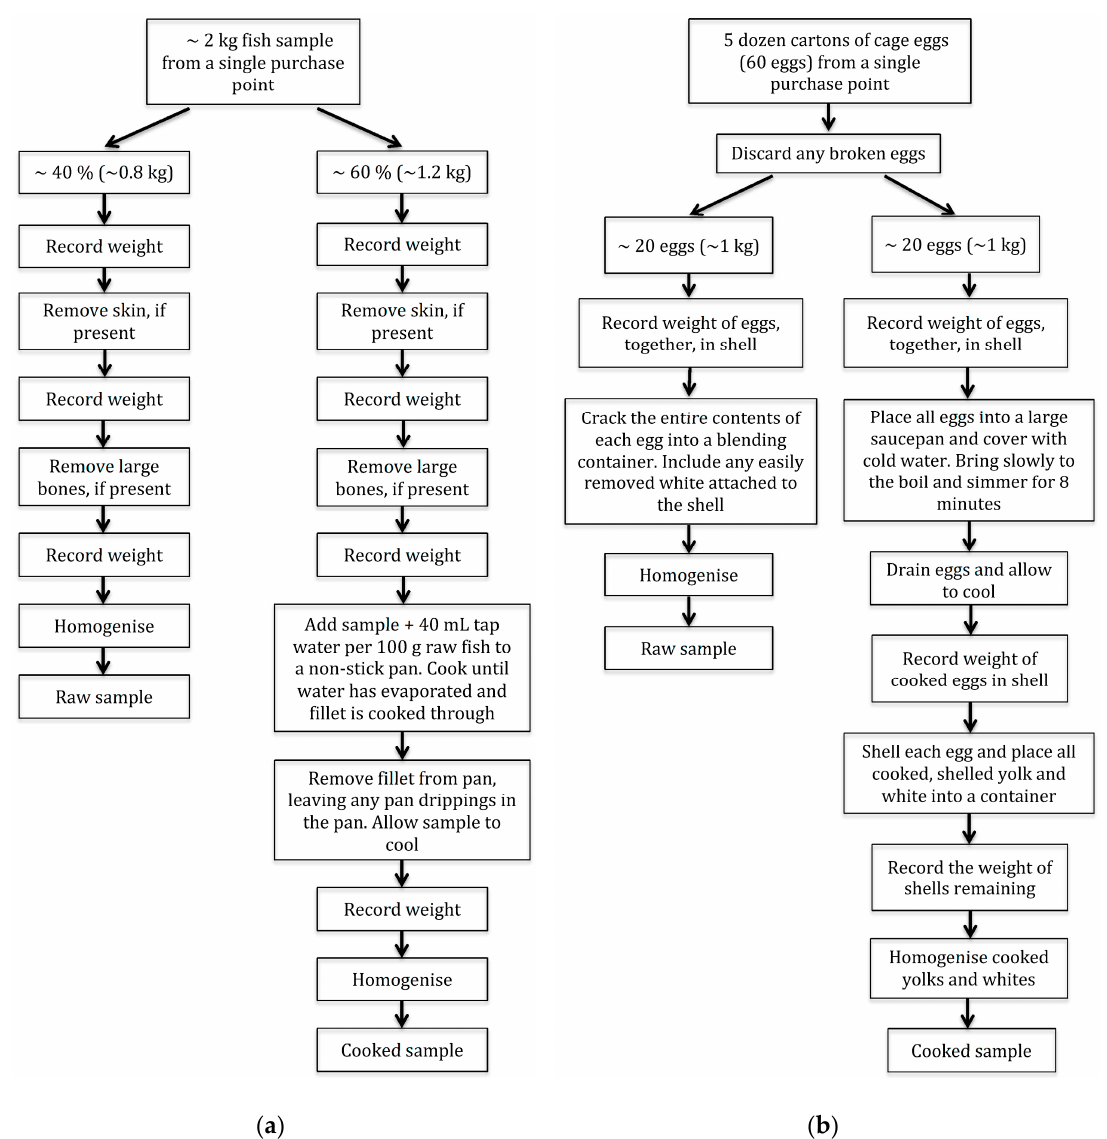
Figure 1. Preparation of ( a ) fish and ( b ) cage eggs for analysis of vitamin D 3 and